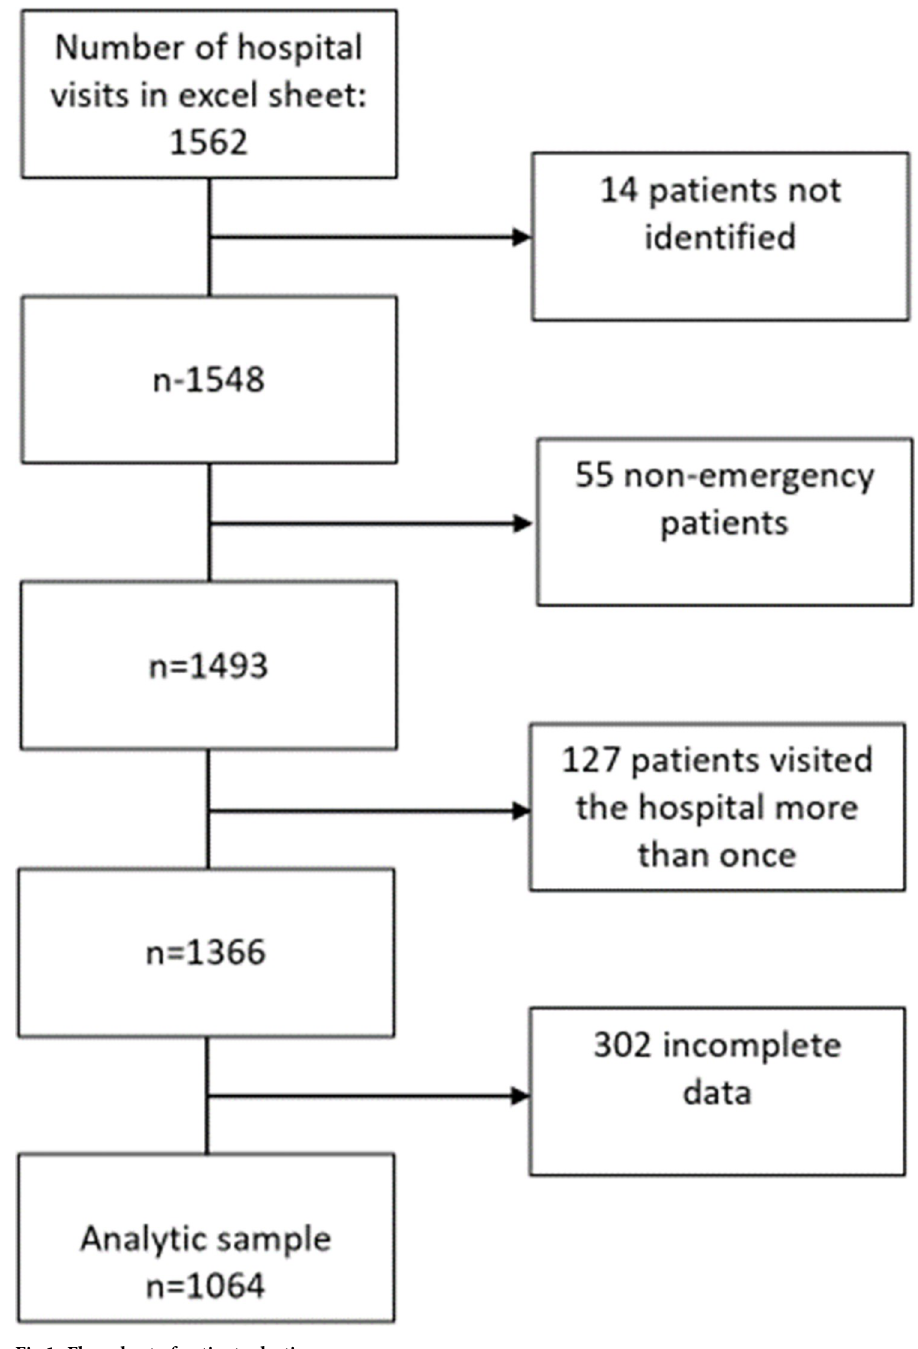
Fig 1. Flow chart of patient